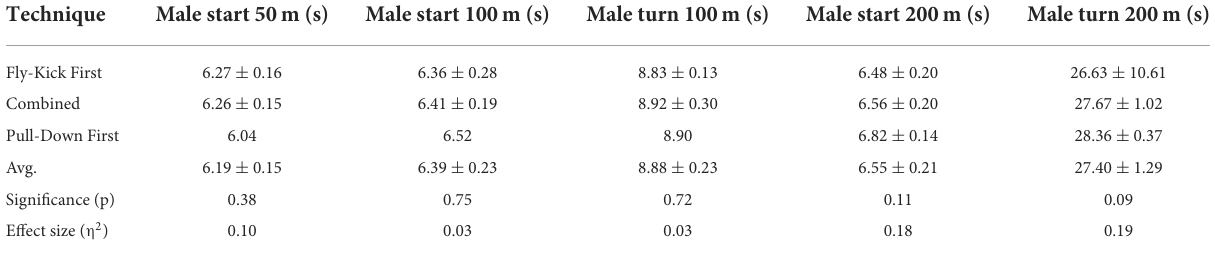
TABLE 2 Male start and turn performances for each of the underwater pullout techniques across the 50, 100, and 200m breaststroke race